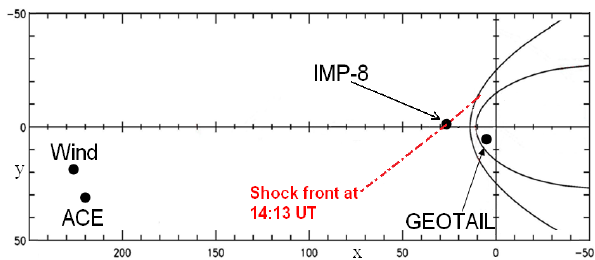
Fig. 2. Locations of the spacecraft used in this study in the XY GSM plane (axis scales in Earth radii, R E